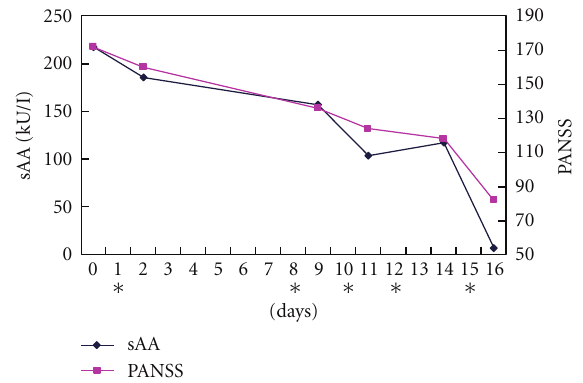
Figure 1: Clinical course. The day before the first ECT operation is defined as day 0. ECT operation days are denoted by an